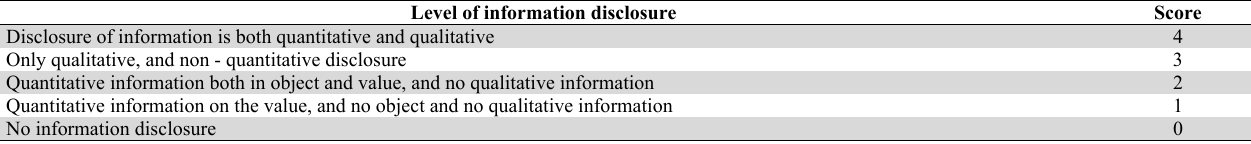
Methods to assess levels of environmental financial accounting practices